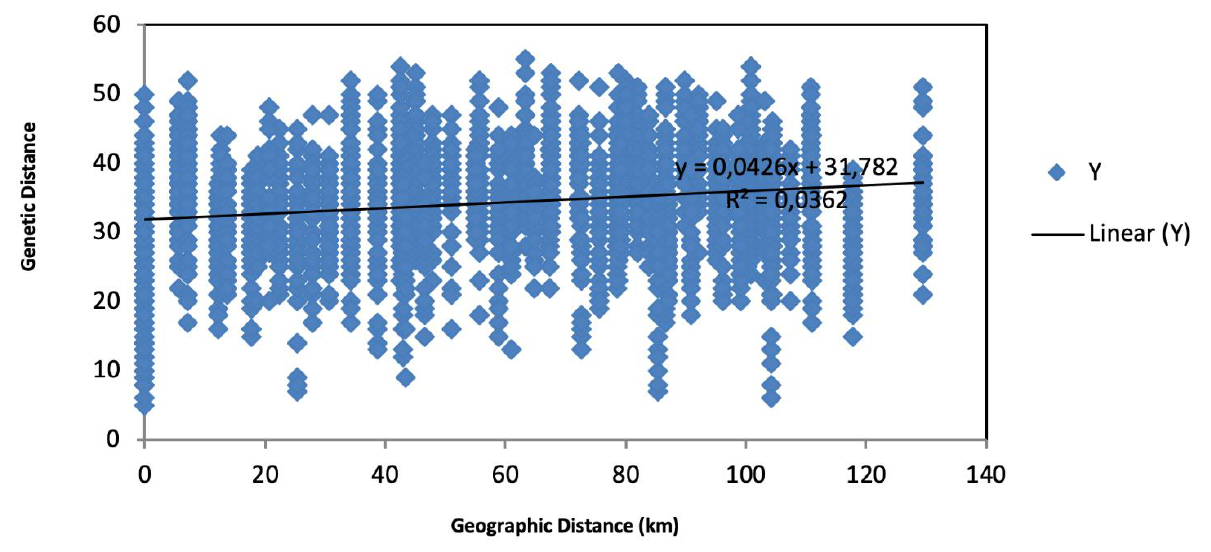
Figure 4. A Mantel test to correlate the genetic distance with geographic distance for the 12 D. rotundifolia